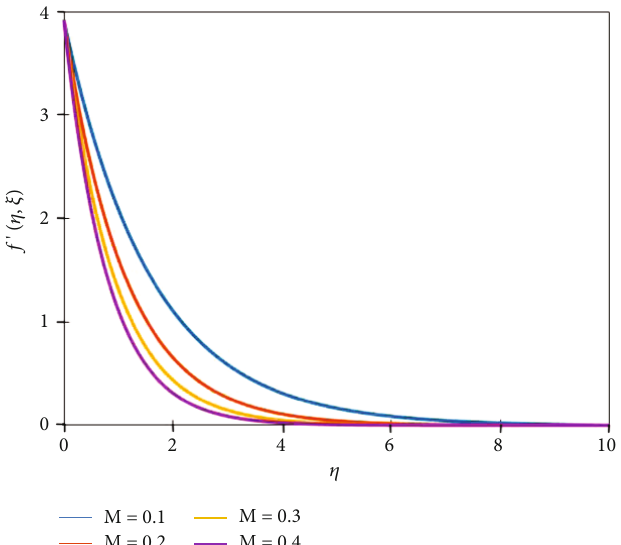
: 8, ξ = 1, N N Df = Bi = Sr = 0 : 5, He = δ = N b = t = w = 0